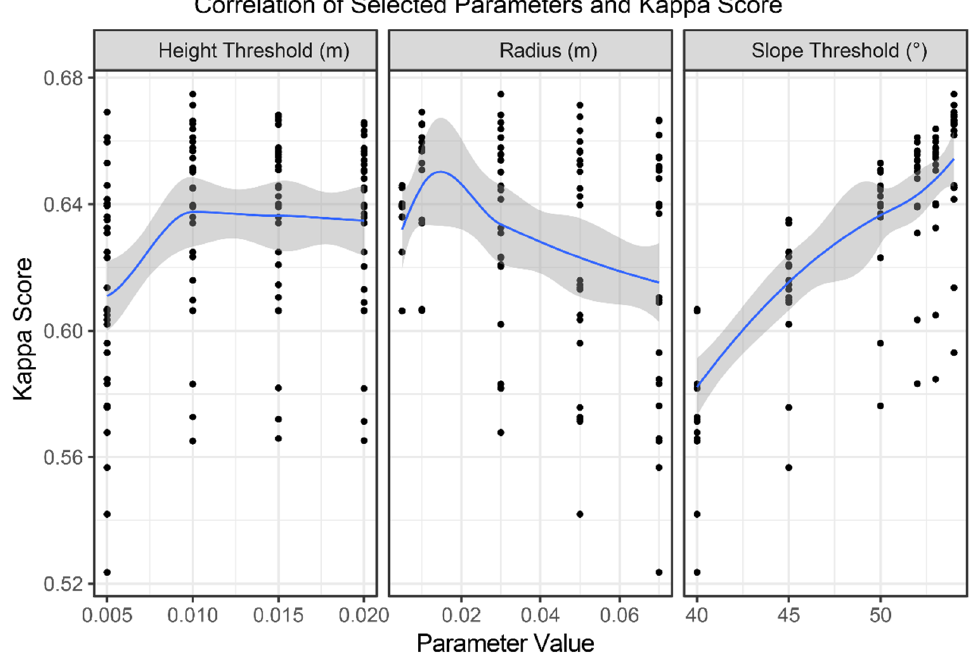
Figure 9. MSBF algorithm parameter performance results by Kappa score. The blue line shows the trendline generated through locally estimated scatterplot smoothing, and the grey areas represent the corresponding confidence interval of 95%.